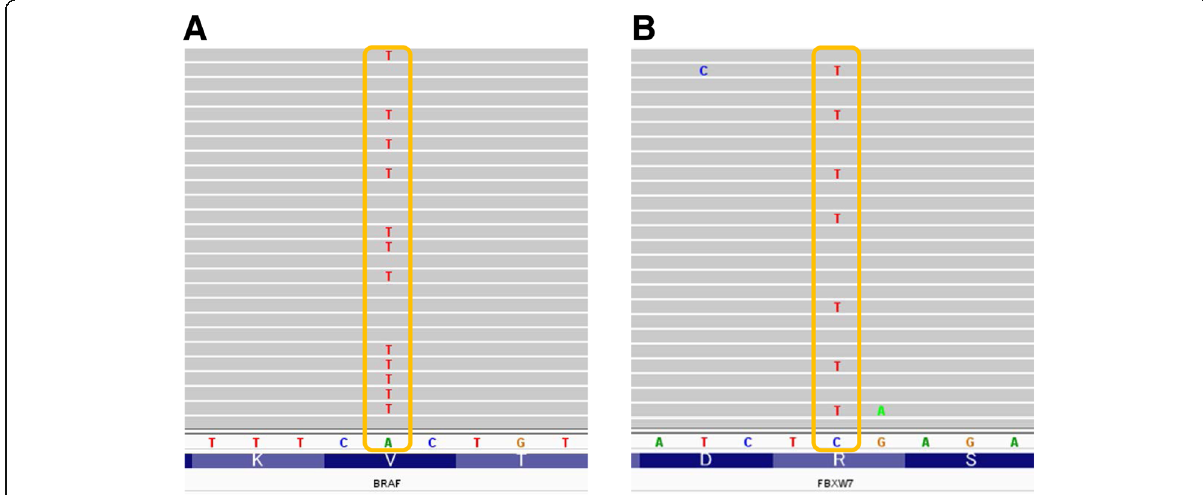
Fig. 3 Representative examples of mutations detected by next-generation sequencing. a Case #1, BRAF mutation, V600E (c.1799 T > A). b Case #3, FBXW7 mutation, R479Q (c.1436 G >